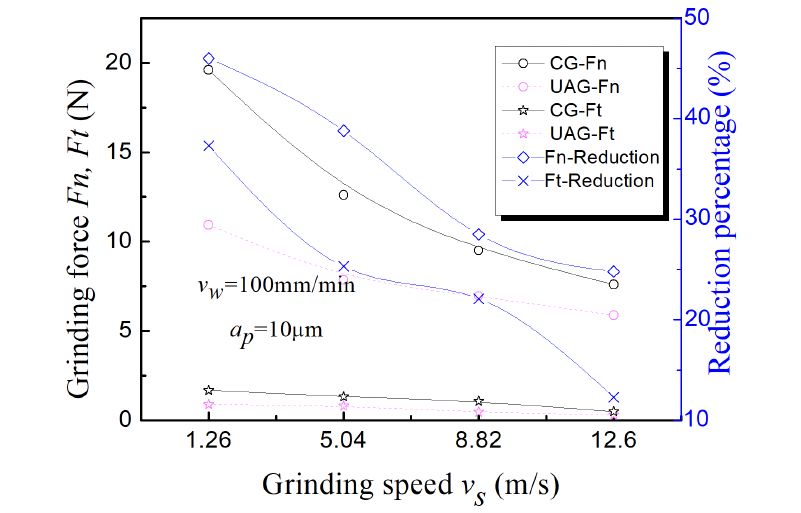
Figure 9. End grinding: the influence of grinding speed changes on the grinding force.